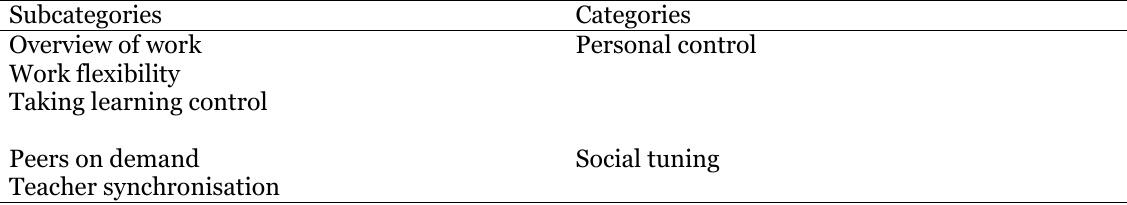
Subcategories and Categories in the Analysis of the Learners’ Experiences of their Learning in the Pilot